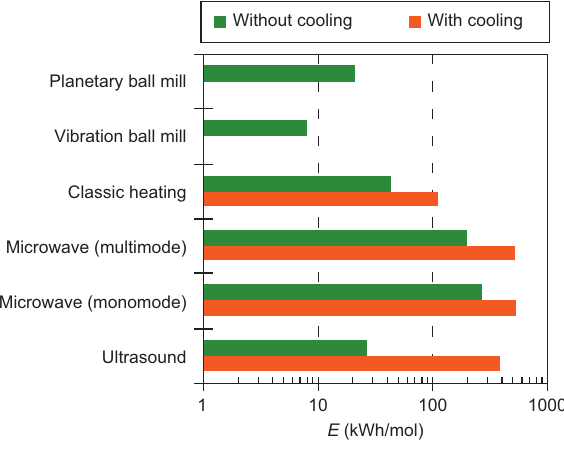
Figure 2 Energy effi ciency for synthesis of azo dye from aniline with different methods of energy entry [24]